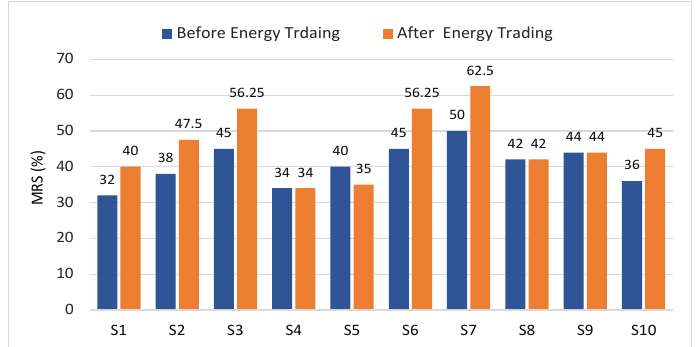
Figure 5. MRS of all sellers after trading in time slot s .